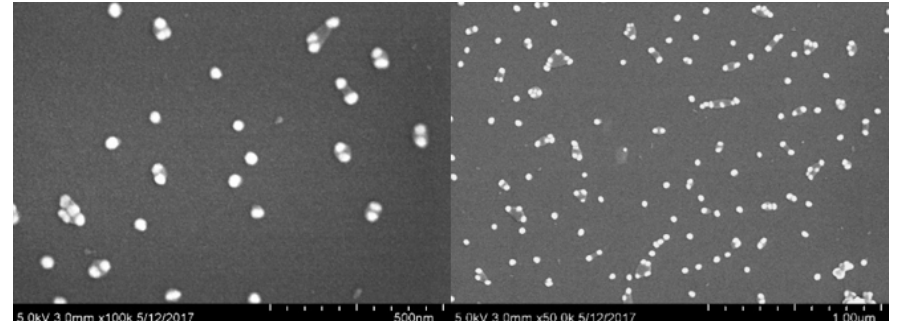
Figure 2. SEM images of Au nanofluids.